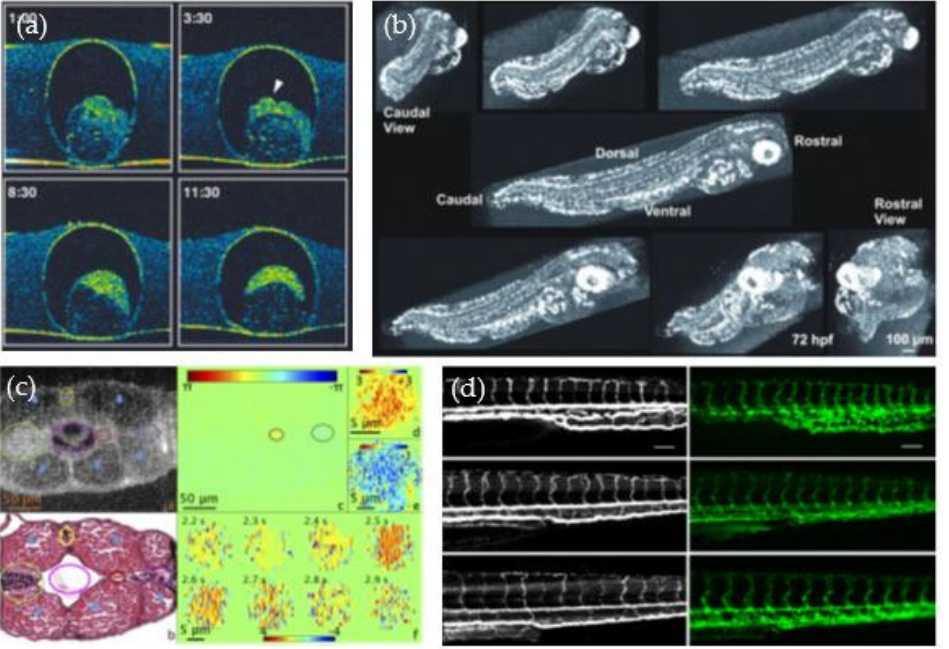
Figure 4. OCT studies performed at early development stages. ( a ) The embryonic development imaged with OCT [52]. Re-print permission was granted by the Creative Commons Attribution license (CC BY 4.0) by Cambridge University Press. ( b ) OCT imaging of a zebrafish larvae [54]. Re ‐ print permission was granted by the authors and Mol. Vis. Journal. ( c ) Doppler OCT reveals blood flow in the trunk of zebrafish larvae quantitatively. Reprinted with permission from Haindl et al. [55] © The Optical Society. ( d ) OCT angiography was used to investigate the blood vessels in the tail of a zebrafish larva [56]. Re ‐ print permission was granted under the Creative Commons (CC BY 3.0)— Gold Open Access by SPIE.